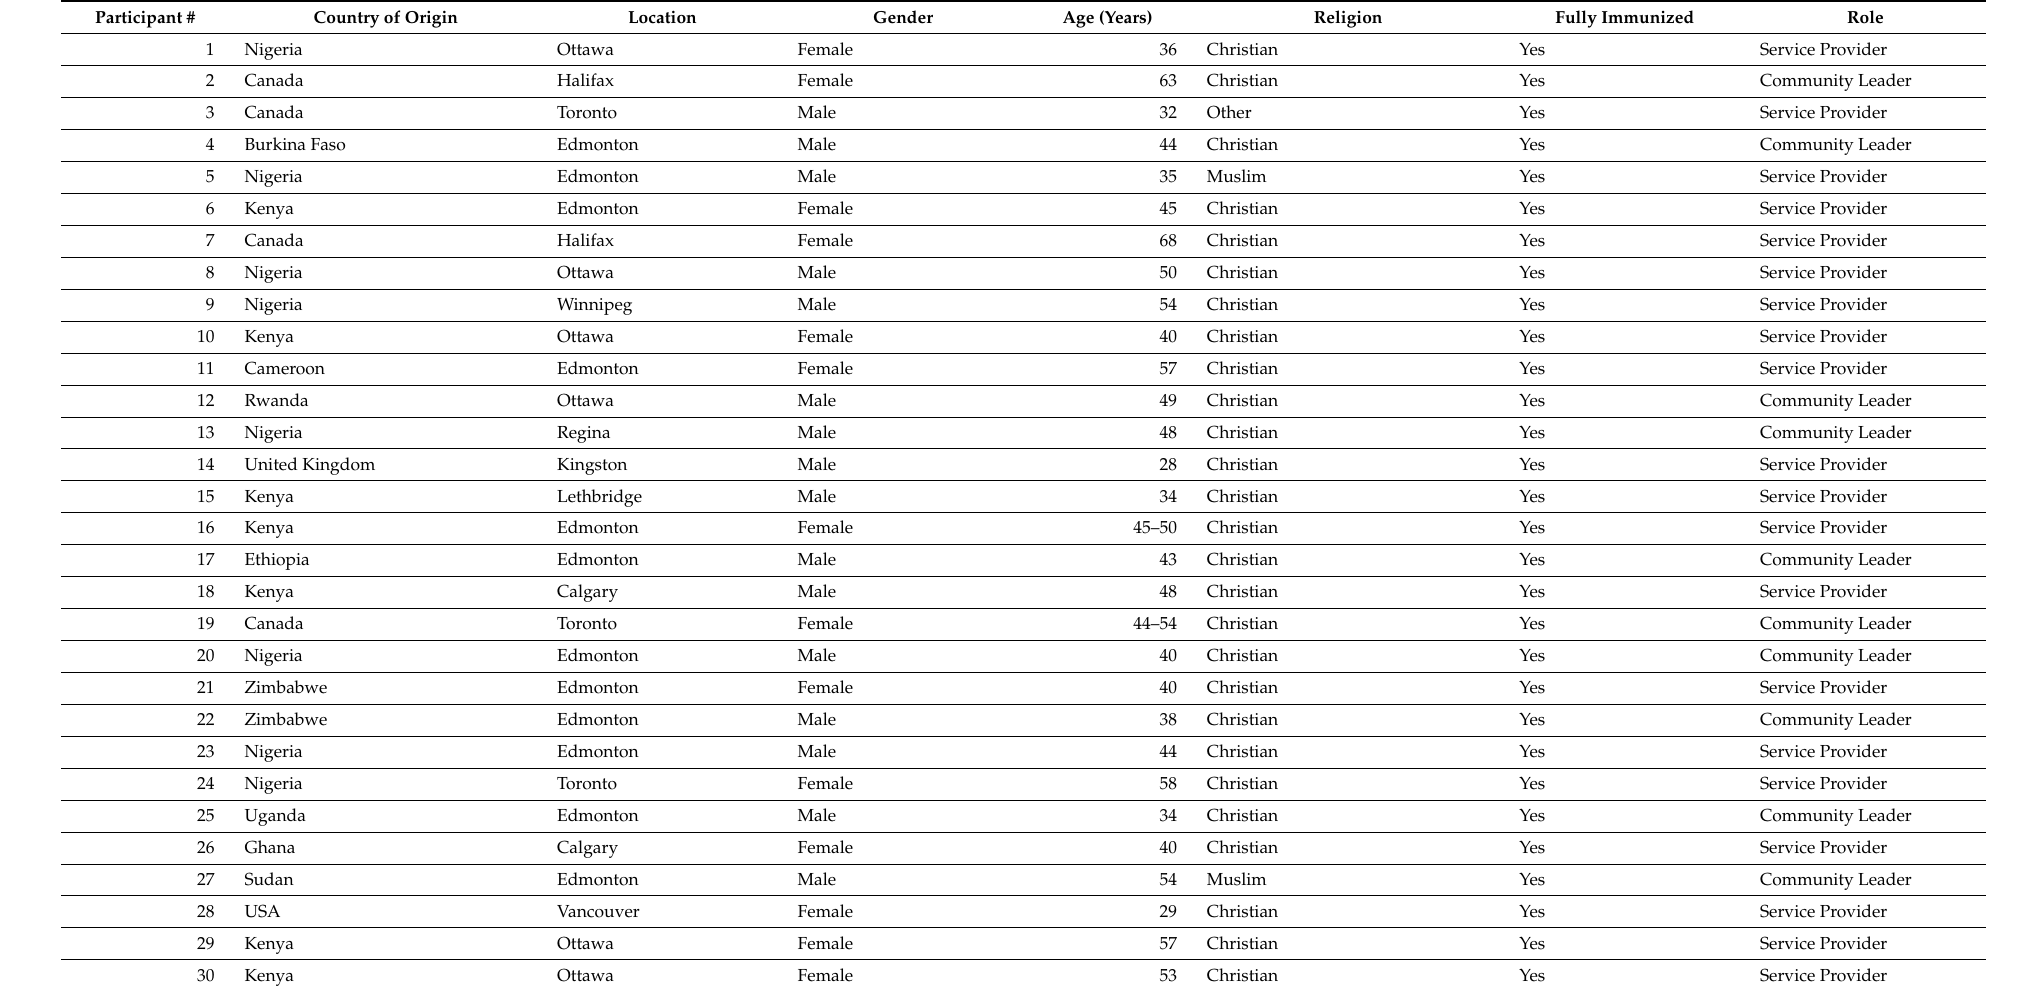
Table 1. Participant sociodemographic